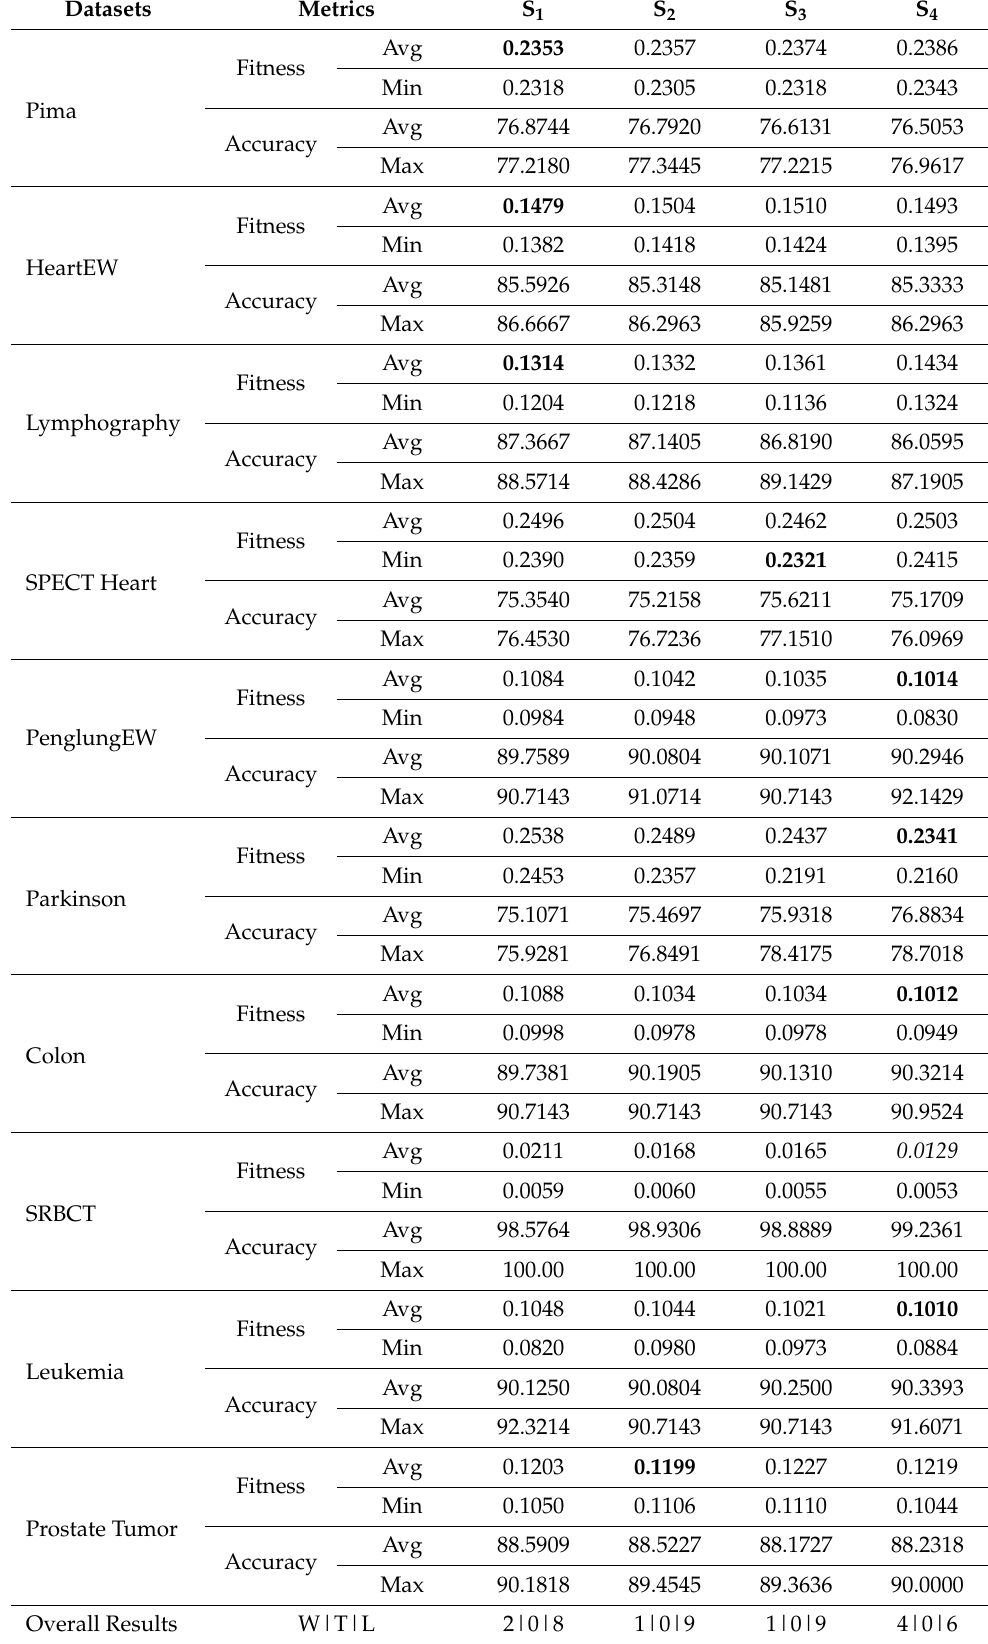
Table A1. The comparison results between different versions of